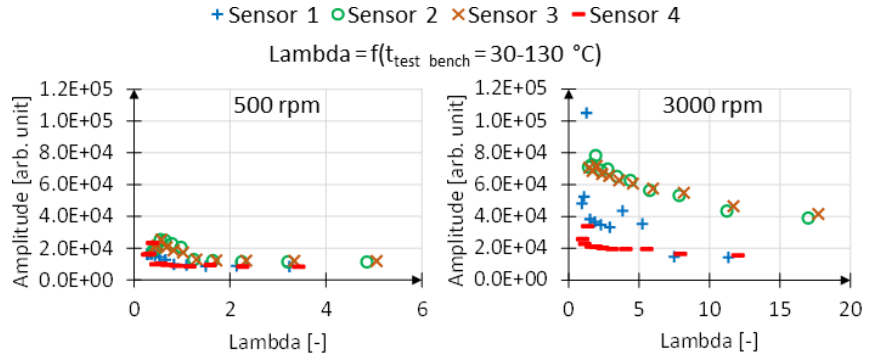
Figure 7. Influence of the lubrication regime and the shaft speed on the AE Energy level. Arb. unit: arbitrary unit.